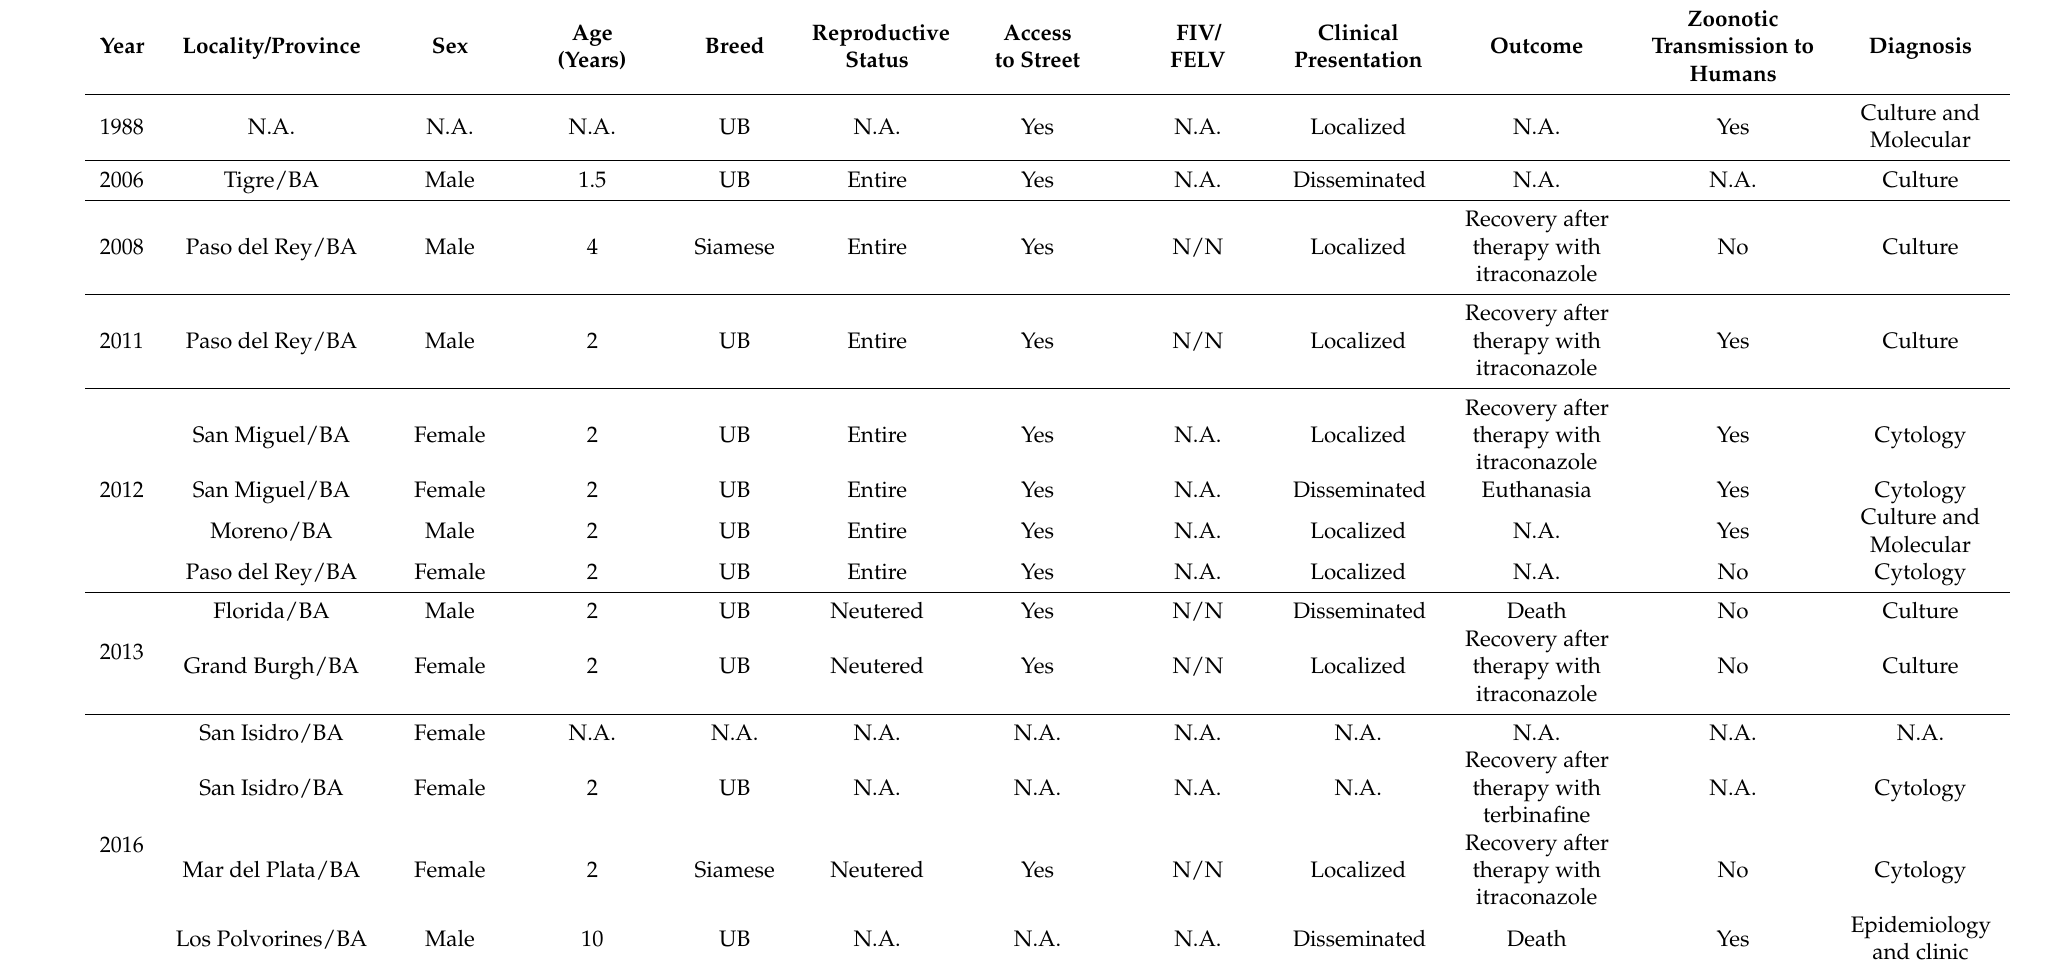
Table 2. Feline cases of sporotrichosis caused by S. brasiliensis in